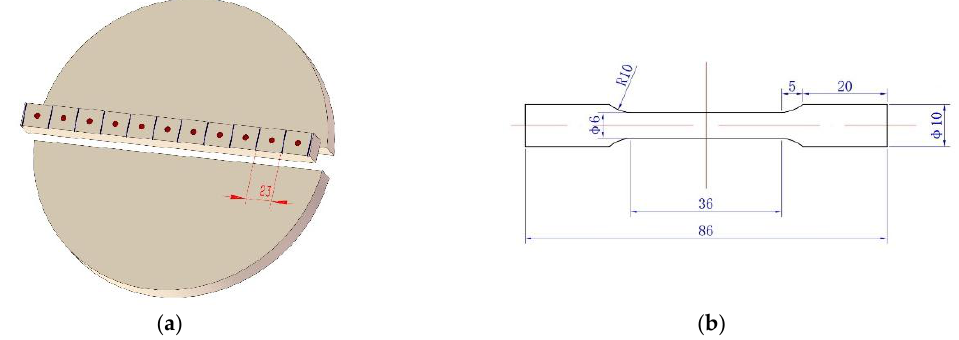
Figure 3. Schematic illustration of ( a ) positions of segregation rate detection; ( b ) tensile samples size.